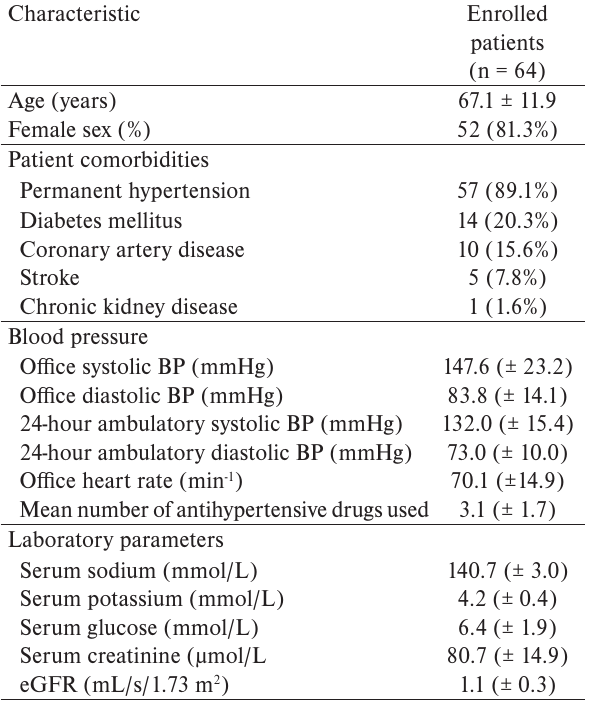
Table 1. Baseline characteristics of